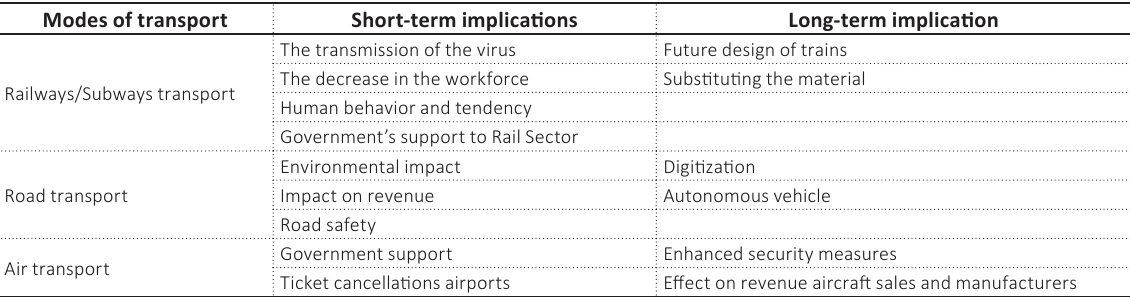
Table 1. Short-term and long-term effects of COVID-19 on modes of transportation Modes of